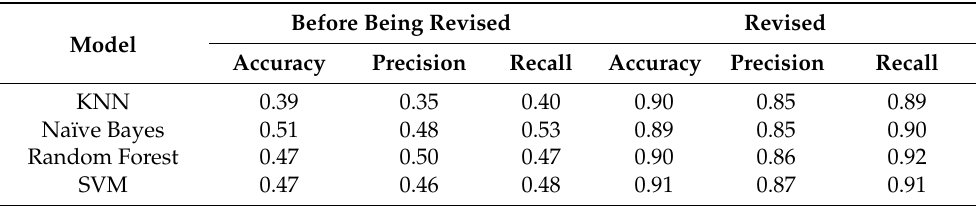
Table 3. The comparison of the four machine learning classifiers results between before and after being revised.